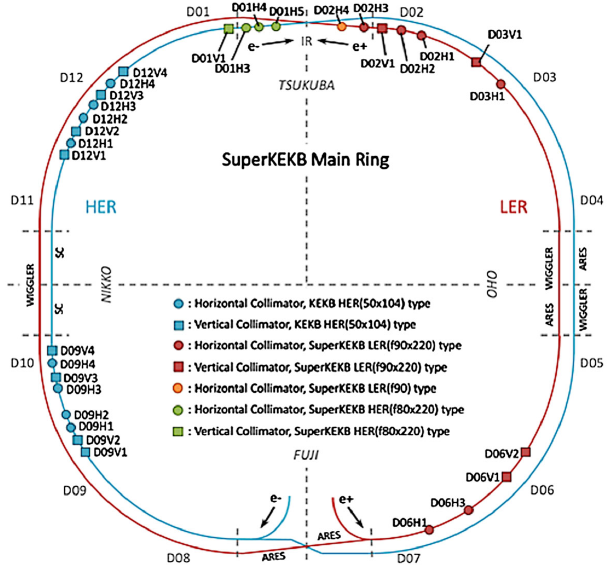
FIG. 26. Location of collimators in the MR, where “ H ” and “ V ” in the collimator names refer to the horizontal and vertical collimators, respectively.